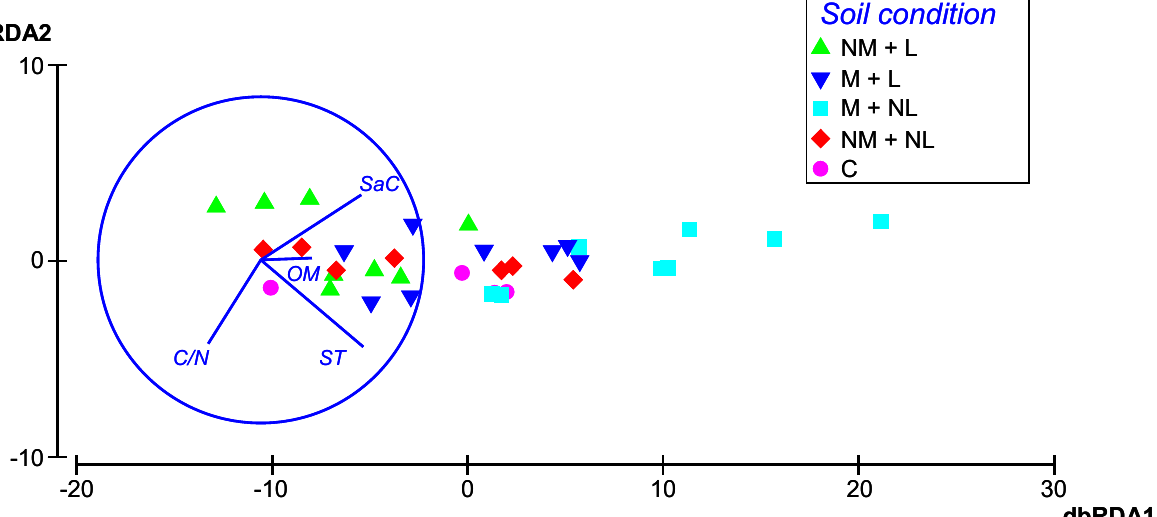
Figure 4. Results of dbRDA (distance-based redundancy analysis) of soil samples that were collected under five soil conditions in the experimental site (Liétor, Castilla La Mancha, Spain). Notes: NM + L = non-mulched and logged; M + L = mulched and logged; M + NL = mulched and non-logged; NM + NL = non-mulched and non-logged; C = control (non-burned); SaC = sand content; ST = soil temperature; OM = organic matter.